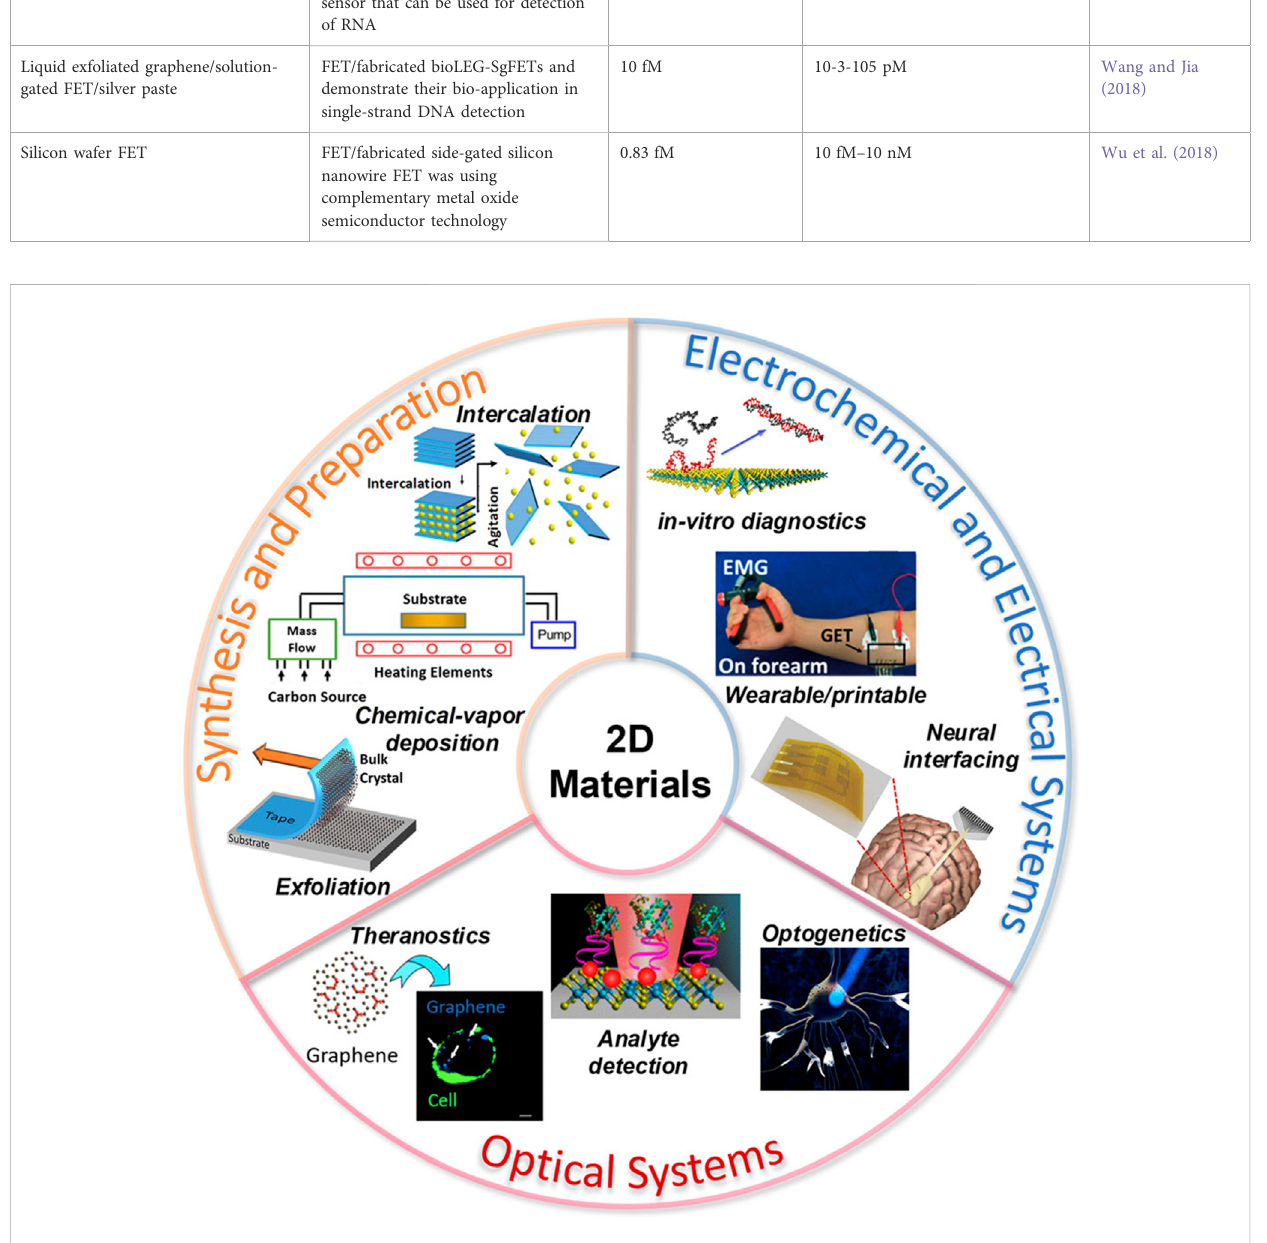
Preparation and synthesis of LD materials for optical and electrochemical applications (Bolotsky et al., 2019).